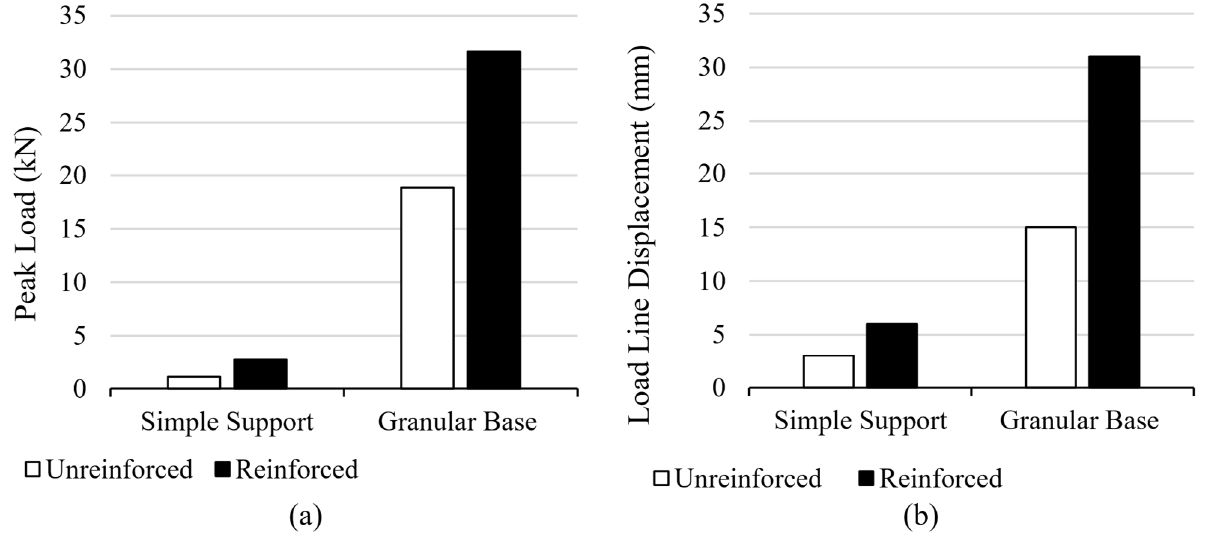
Figure 9. Comparison between the results obtained from ( a ) peak load and ( b ) load-line displacement for the testing samples.